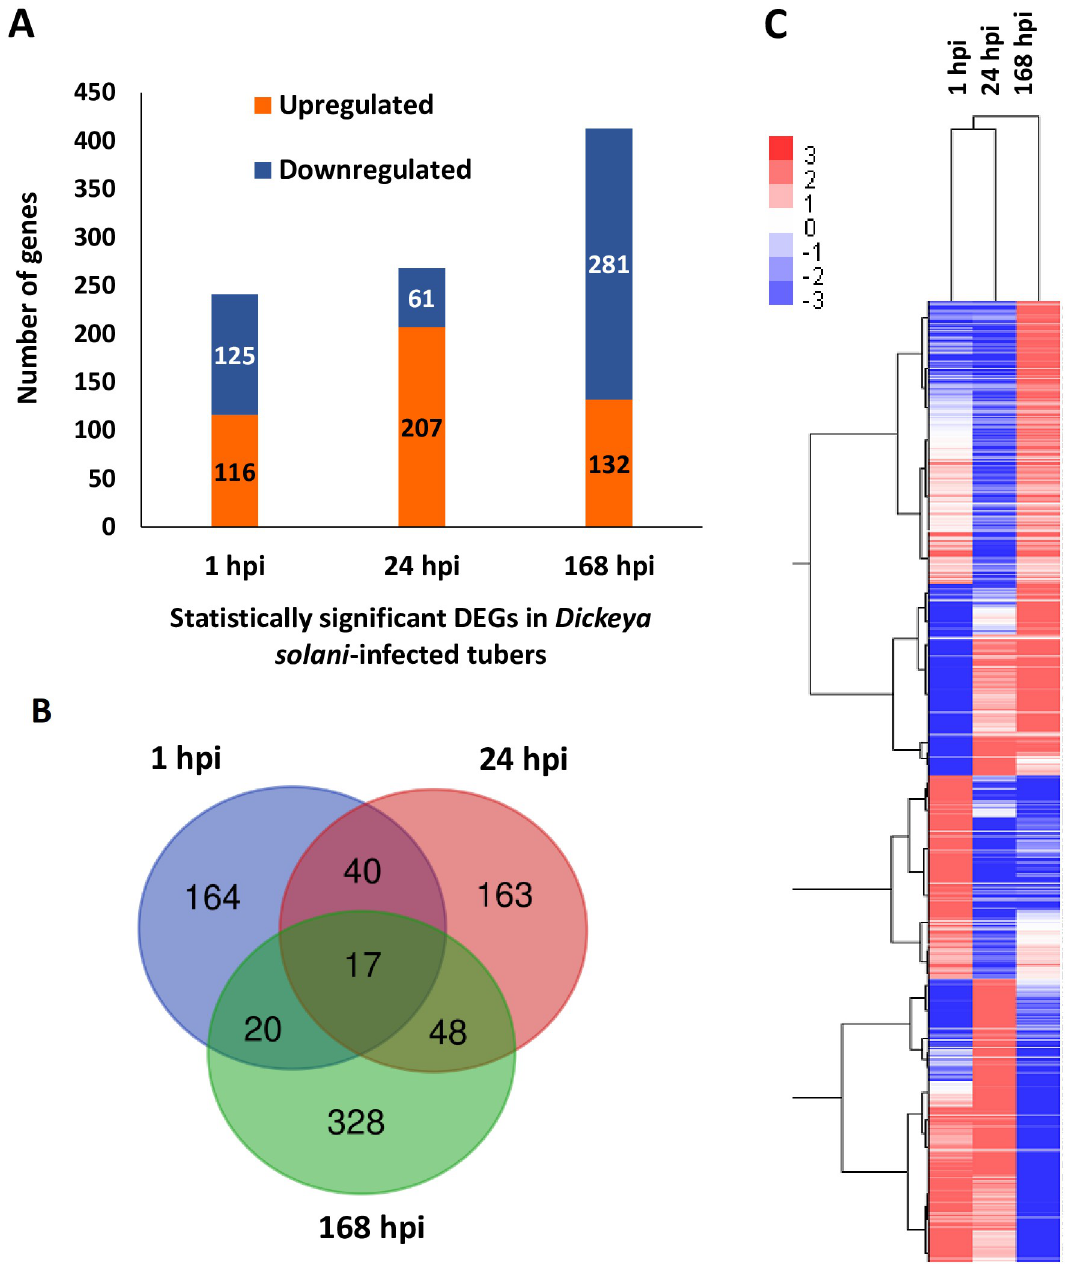
Fig 2. Gene expression changes in potato tubers 1, 24 and 168 h postinoculation (hpi) with D . solani . A The numbers of statistically significant DEGs that were either up- or downregulated at each time point (1, 24 and 168 hpi) in comparison between pathogen- and mock-treated control tubers. B Venn diagram analysis of the DEGs showing the overlaps of the genes between different time points in each comparison. C Heatmap based on clustering of 542 DEGs identified with NOISeq with probability > 0.8, p-value < 0.05 and log2 fold change � 2 and � − 2 at one or more of the time points. Hierarchical clustering suggests that the 1 and 24 hpi samples clustered together. The scale bar represents relative expression values, red indicates upregulated genes, blue indicates downregulated genes and white indicates genes whose expression levels were unchanged between inoculated and control tubers.